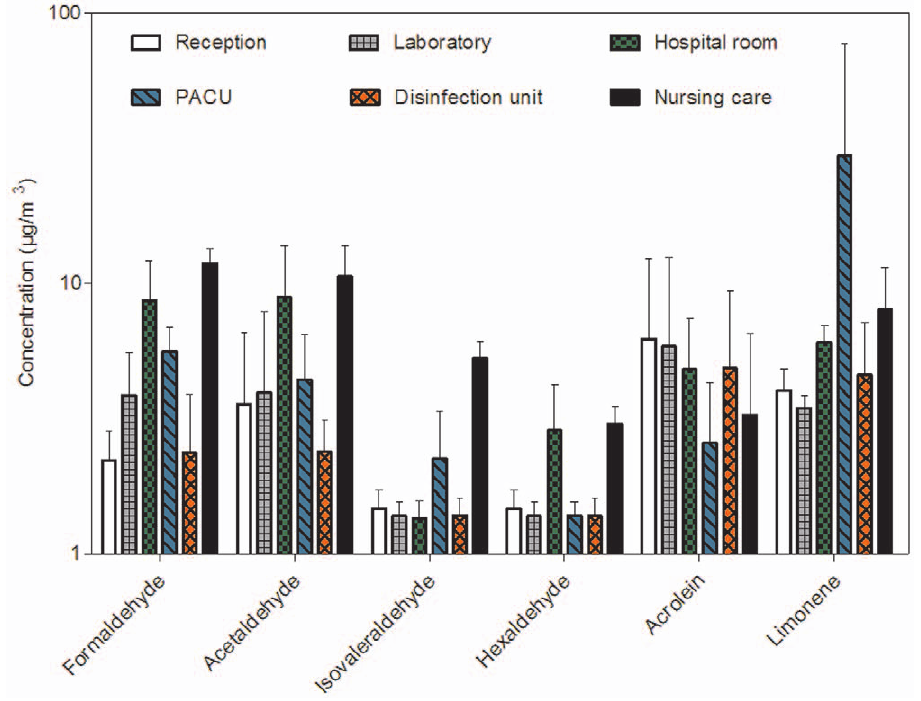
Figure 4. Comparison of aldehydes and terpenes concentrations (arithmetic mean ± SD on a logarithmic scale) in the six sampling sites.